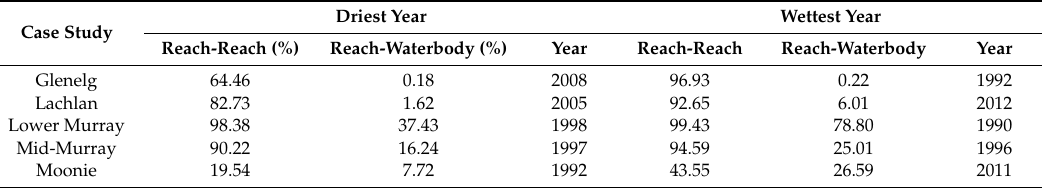
Table 4. Percentage of reaches within the catchment where hydrologic connectivity